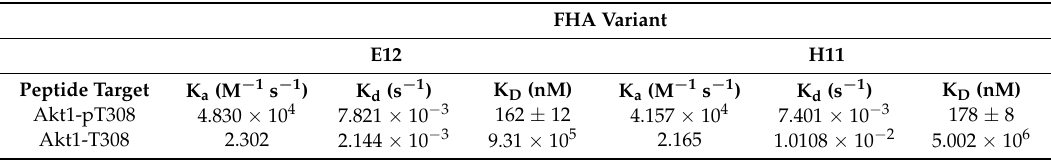
Figure 4. Comparing the relative affinity of four clones. ( A ) Competition binding of clone B3, E1, H11 and E12 to immobilized phosphorylated Akt1 peptide in the presence of free phosphorylated peptide. Error bars represent standard deviation of triplicate measurements. ( B ) IC 50 values for each clone to the Akt1 phosphorylated peptide. Table 1. Affinity measurements of FHA clone E12 and H11 to the phosphorylated (Akt1-pT308) and unphosphorylated (Akt1-T308) peptides.